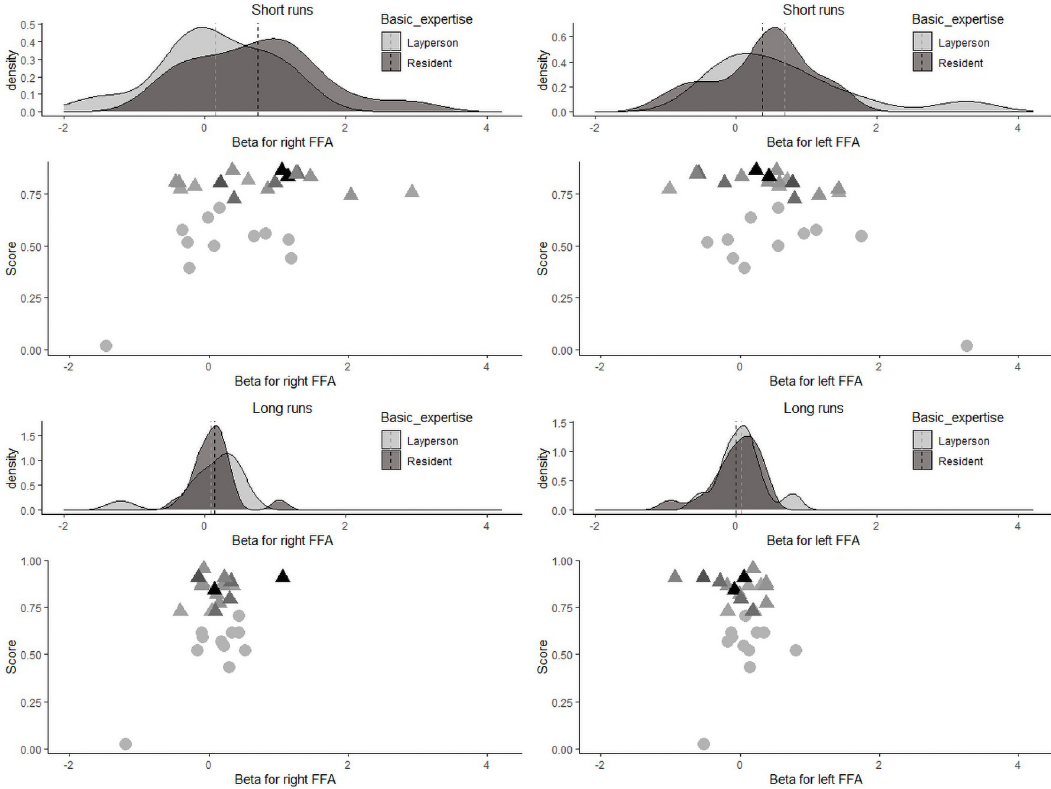
Fig 5. Density plots (upper panels) and scatter plots (lower panels) for the individual beta values in the FFA for short- and long-presentation trials for correctly diagnosed trials only. In the upper panels, the dotted line denotes the group mean. In the lower panels, for residents, darker colors depict more experienced